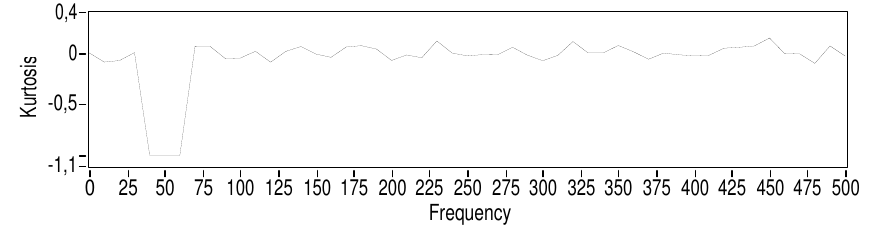
Figure 1. Spectral kurtosis (SK) analysis over a healthy signal. SK results corresponding to a 50 -Hz sinusoid with additive Gaussian noise with ( σ = 0 . 05 ), swept from 0 to 500